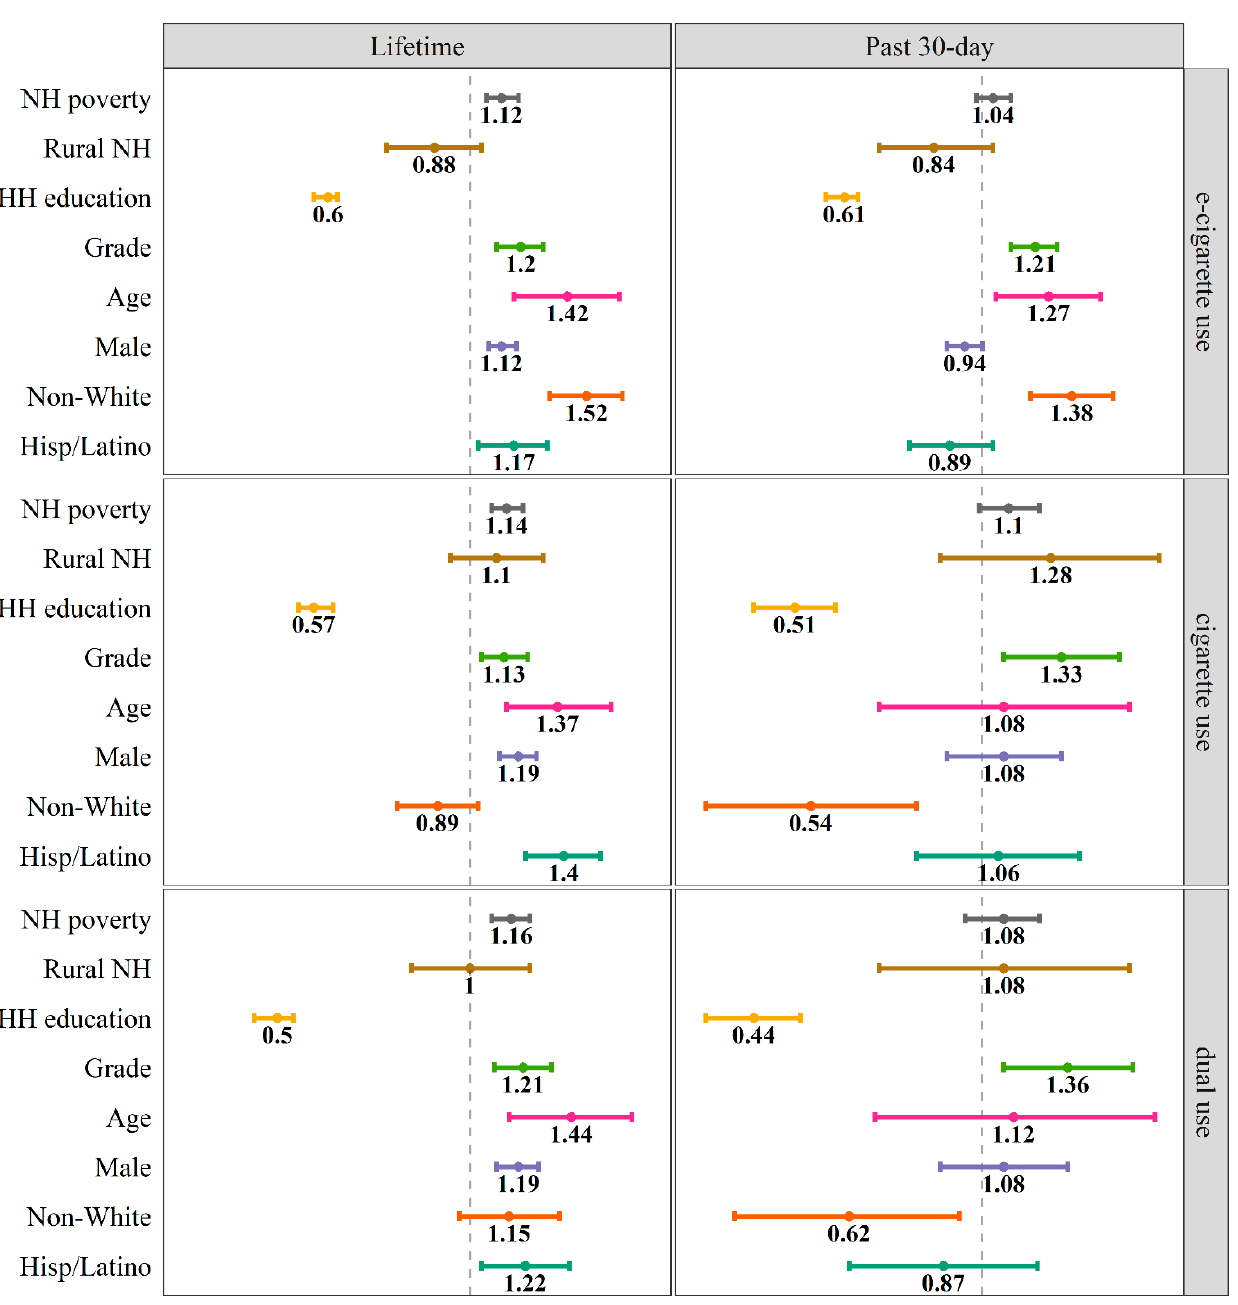
Figure 1. Adjusted odds ratios and 95% confidence intervals from logistic regression models for neighborhood- and individual-level associations with lifetime and past 30-day e-cigarette, cigarette, and dual use. NH = neighborhood and HH = household. NH poverty and age were standardized prior to modeling. Confidence intervals crossing the dotted line indicate p > 0.05, and the x -axis is presented on the logarithmic scale.